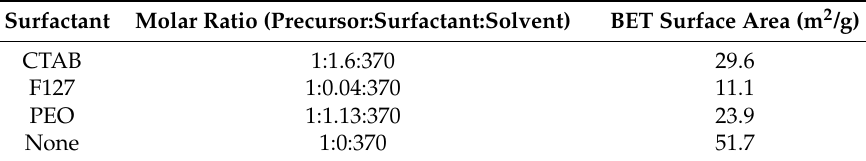
Figure 1. Representative scanning electron microscope (SEM) images of gallium oxide nanoplates with different aspect ratios (length/diameter; L/D) synthesized using different surfactants. ( a ) L/D = 7:1 using CTAB (Cetyl Trimethyl Ammonium Bromide) as surfactant; ( b ) L/D = 11:1 using F127 (Pluronic F-127) as surfactant; ( c ) L/D = 12:1 no surfactant; and ( d ) L/D = 24:1 using PEO (Tergitol-S-7) as surfactant. Table 1. Catalyst general synthesis conditions.